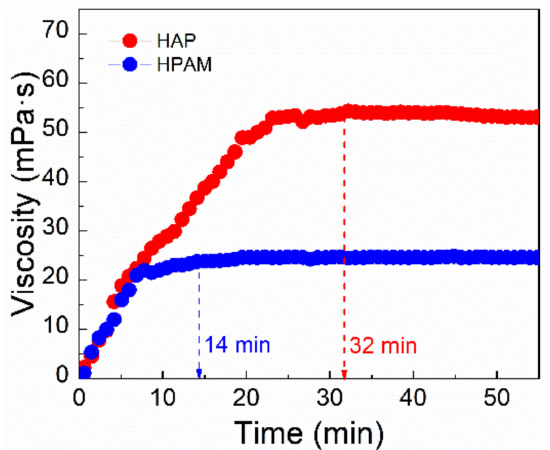
Figure 4. The apparent viscosity variation of HAP and HPAM solutions with dissolving time in Bohai seawater at 75 ◦ C (Particle size of polymer powder, 40–120 mesh; polymer concentration, 0.175%; shear rate, 7.34 s − 1